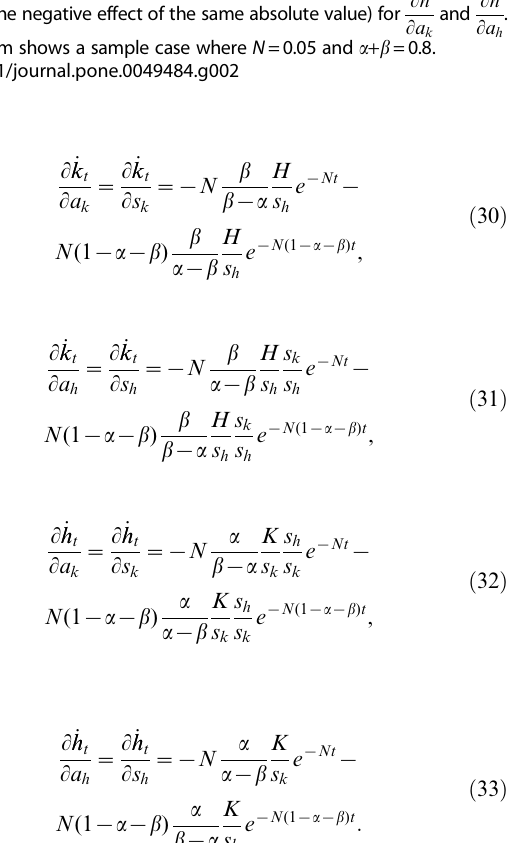
N H L _ kk t ~ b s h a { b L a k H b N is constant and, if a . b , s h a { b H b N . Equivalently, the curve shown in the s h a { b L k and opposite L a h L h L h and . L a k L a h